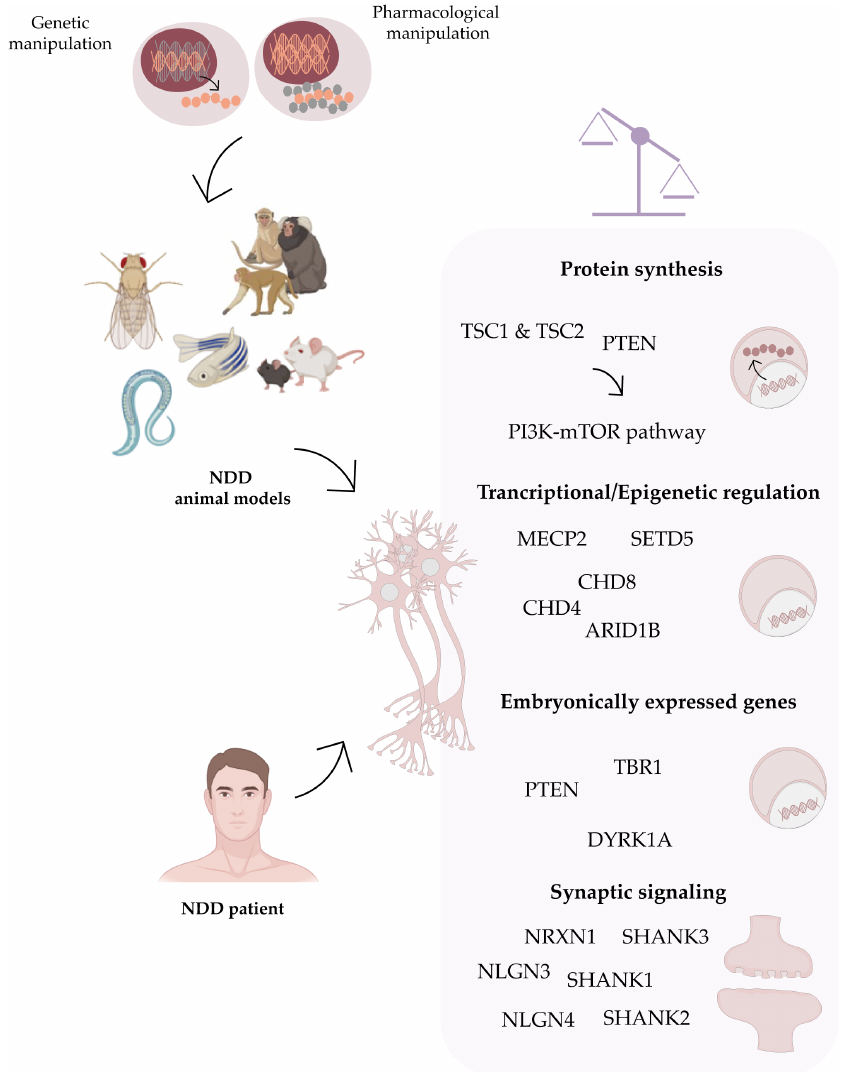
Figure 1. NDD-causing gene variants are often responsible for homeostatic imbalances in protein synthesis early in development, in many cases specifically through impairment of phosphatidylin- ositol 3-kinase (PI3K)-mammalian target of rapamycin (mTOR) pathway [37–40]. mTOR is a ser- ine/threonine kinase composed by two complexes (mTORC1 and mTORC2) responsible for cellular metabolism. Hyperactivation of mTOR due to variants affecting negative regulators of the PI3K- mTOR growth factor pathway (such as hamartin (TSC1), tuberin (TSC2) and PTEN) has already been reported in NDD-dominant patients with ASD, ID and epilepsy [41,42]. Other NDD-causing genes belong to the transcriptional regulators and chromatin remodelers category [43], which is the case of methyl CpG binding protein 2 (MECP2), chromodomain helicase DNA binding (CHD) [44,45], AT-rich interactive domain-containing protein 1B (ARID1B) [46] and SET-domain contain- ing 5 (SETD5) [47]. Due to the multiplicity of targets, dysregulation of these epigenetic effectors might mediate several disease phenotypes [44,45,47–68]. Among the embryonically expressed genes shown to be altered in NDDs, T-box brain transcription factor 1 (TBR1) [48–52], dual specificity tyrosine phosphorylation regulated kinase 1A (DYRK1A) [53–61] and phosphate and tensin homo- log (PTEN) [62–66] are the ones in which gene variants are most commonly reported. Another key contributor for brain function and homeostasis is synaptic signaling, responsible for the communi- cation between cells forming neuronal circuits. Loss-of-function mutations in neurexin 1 ( NRXN1 ) [69–79], in neuroligins (NLGN) such as NLGN3 and NLGN4 genes [67,68,80–85] and in SH3 and multiple ankyrin repeat domain (SHANK) proteins encoding genes SHANK1 , SHANK2 and SHANK3 have been widely associated with ASD and ID [86–89].